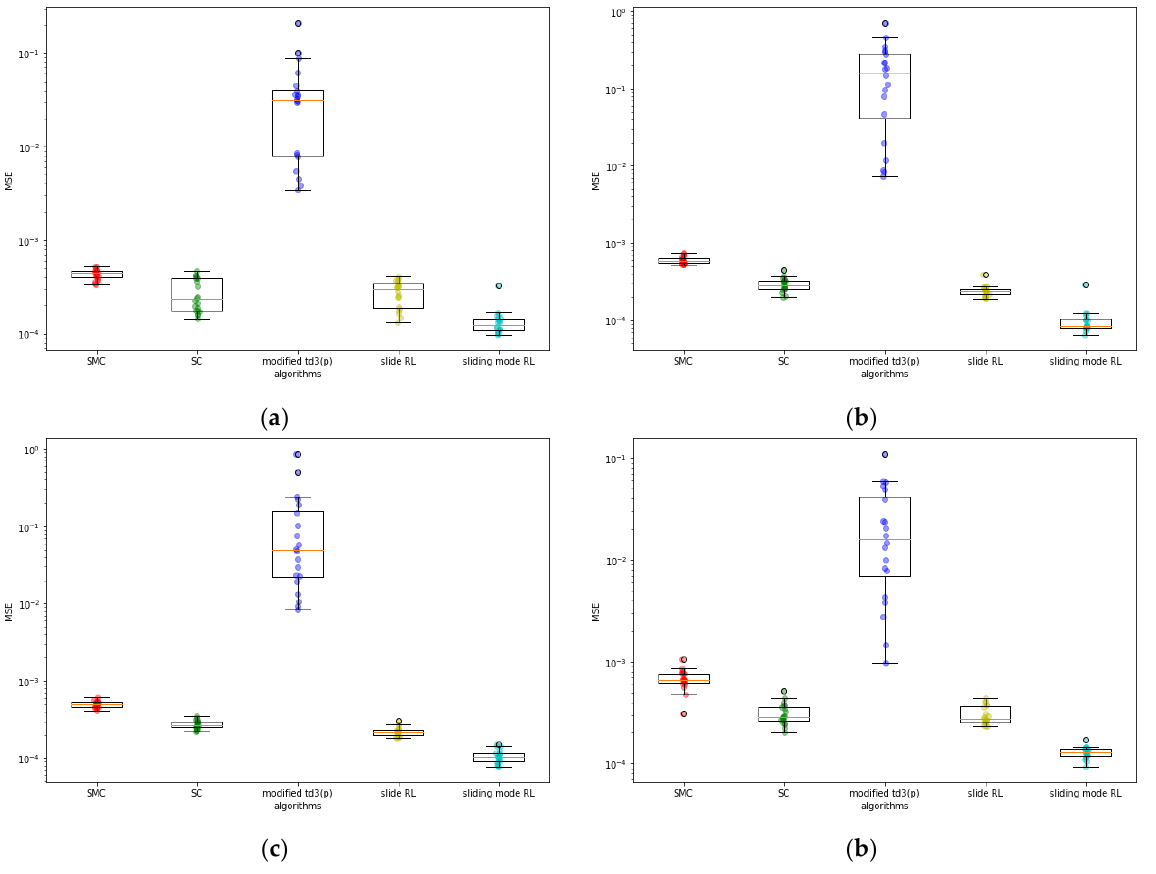
Figure 4. Box plot of MSEs: ( a ) case1; ( b ) case3; ( c ) case4; ( d ) case6.